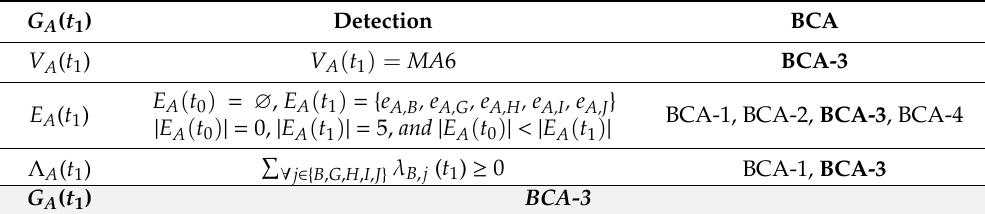
Figure9. ( a )NetworkstructureofScenario3andthestatusofBCAfromhost A tohost J .( b )Experimental Figure 9. ( a ) Network structure of Scenario 3 and the status of BCA from host A to host J . ( b ) results of S 7 on host A to host J . Experimental results of S 7 on host A to host J . Table 8. BCA-3 detection on host A at t 1 in Scenario